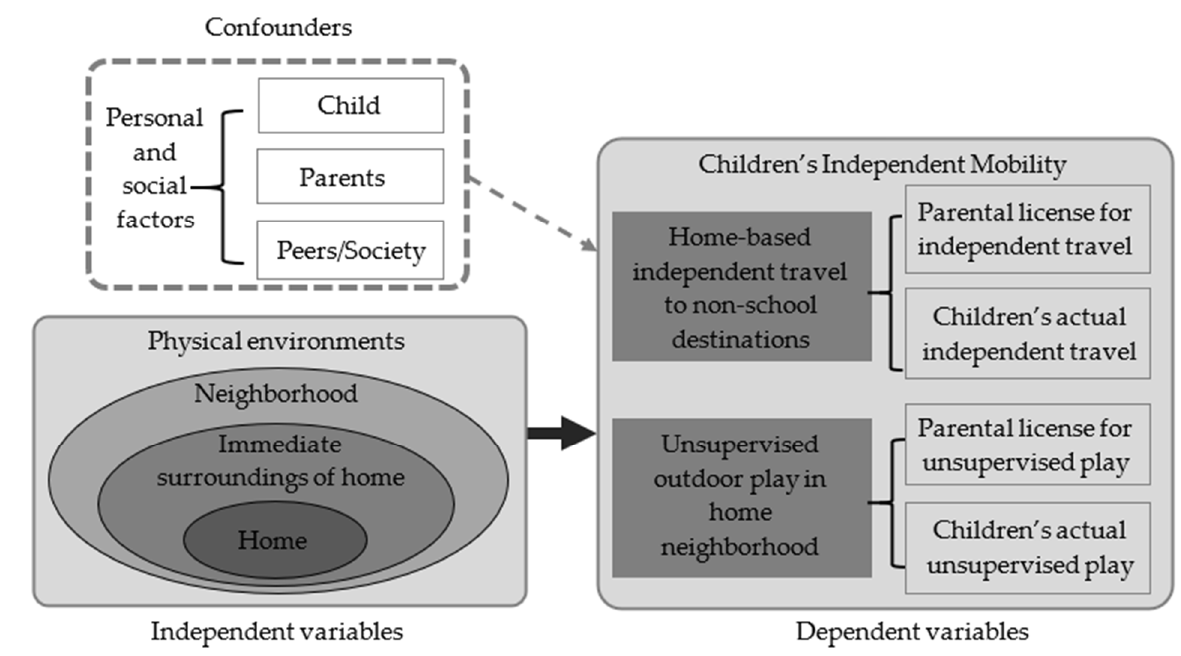
Figure 1. Conceptual framework about multilevel factors affecting two modes of children’s independent mobility.